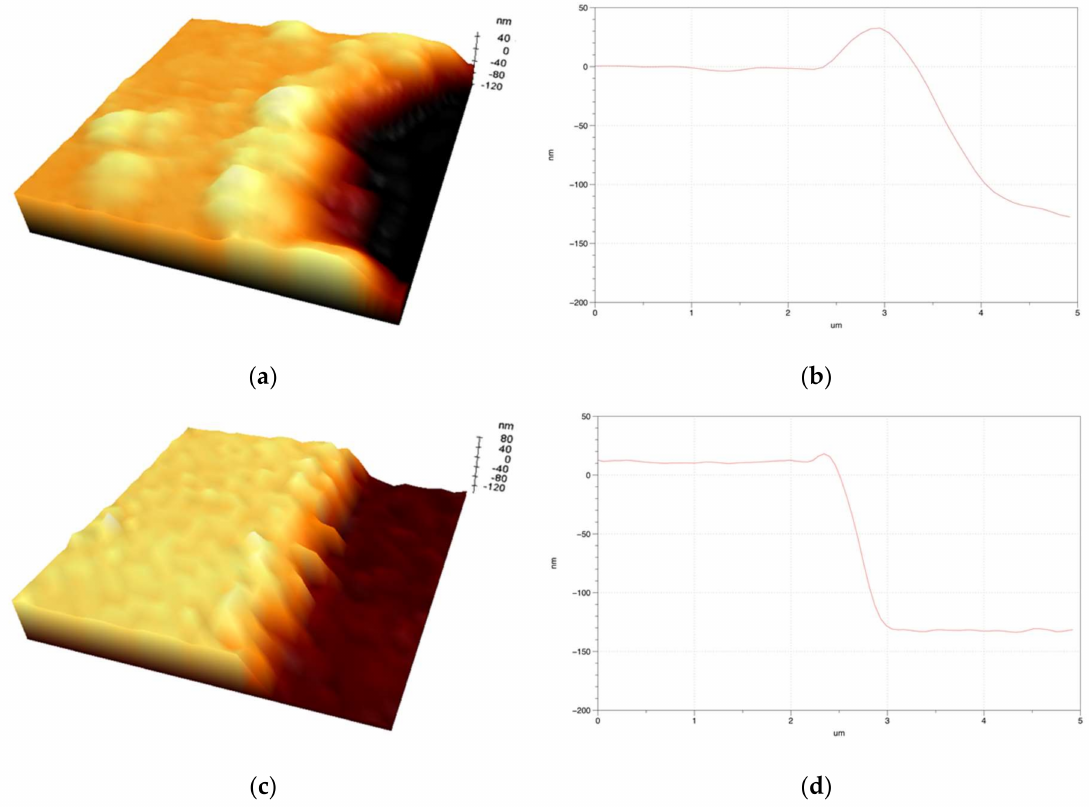
Figure 6. Images of the enlarged AFM three-dimensional (3D) morphology ( a ) with Gaussian beam irradiation, and ( c ) with quasi-flat top beam irradiation. The cross-sectional graph of the ablation edge obtained from the enlarged AFM image ( b ) with Gaussian beam irradiation, and ( d ) with quasi-flat top beam irradiation.